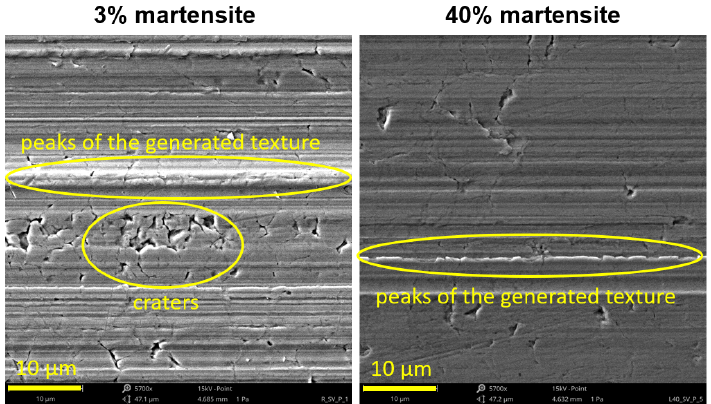
Figure 6. SEM micrographs showing the main details of UVABB